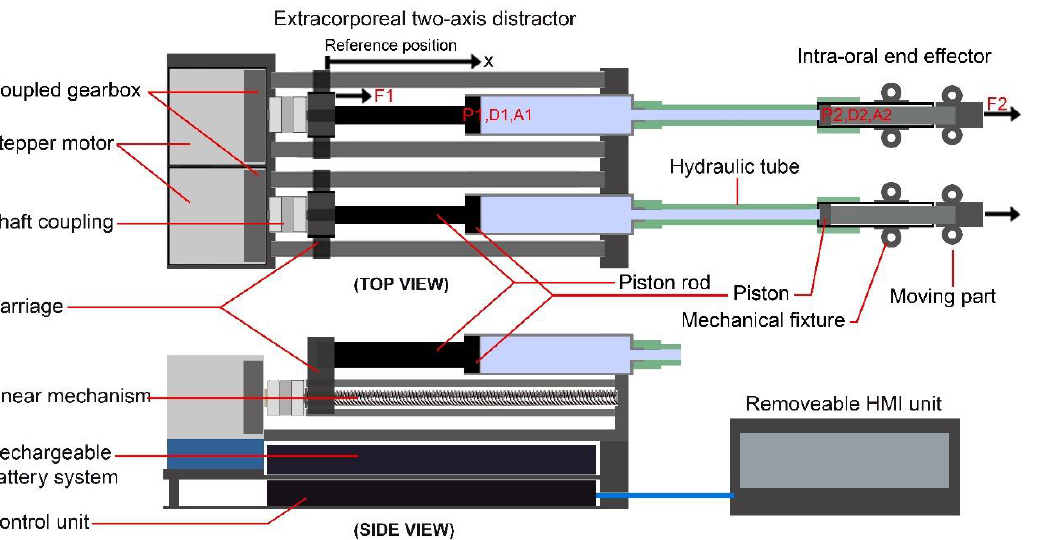
Figure 6. The schematic design of the mechanism for generating and transmitting two independent continuous forces with the end-effector-controlled positioning.